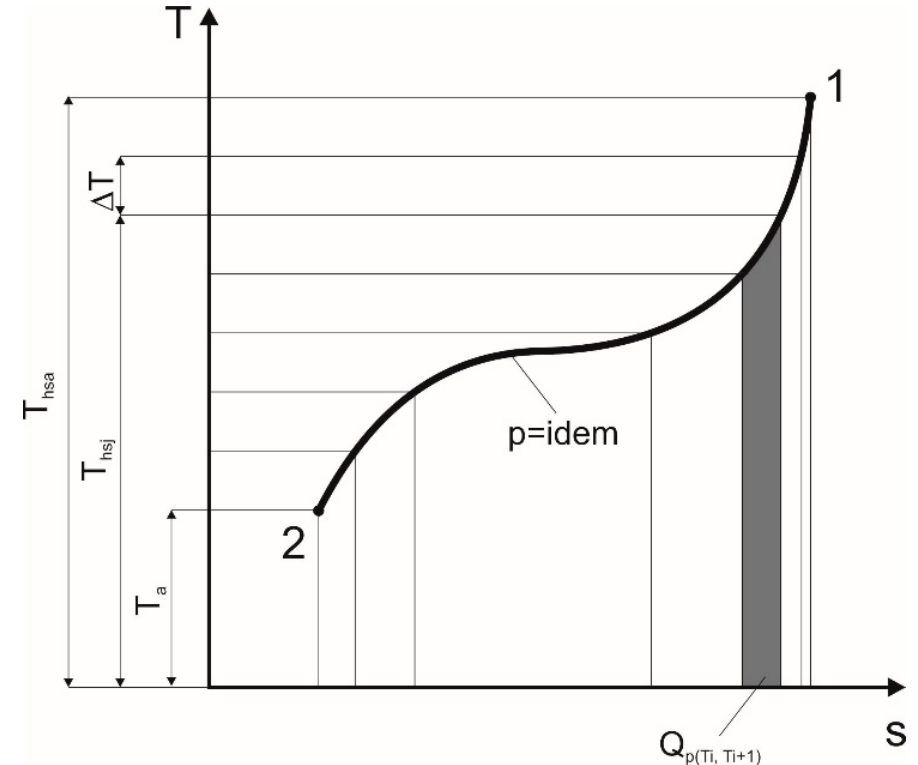
Figure 3. The process of isobaric cooling of the heat source.